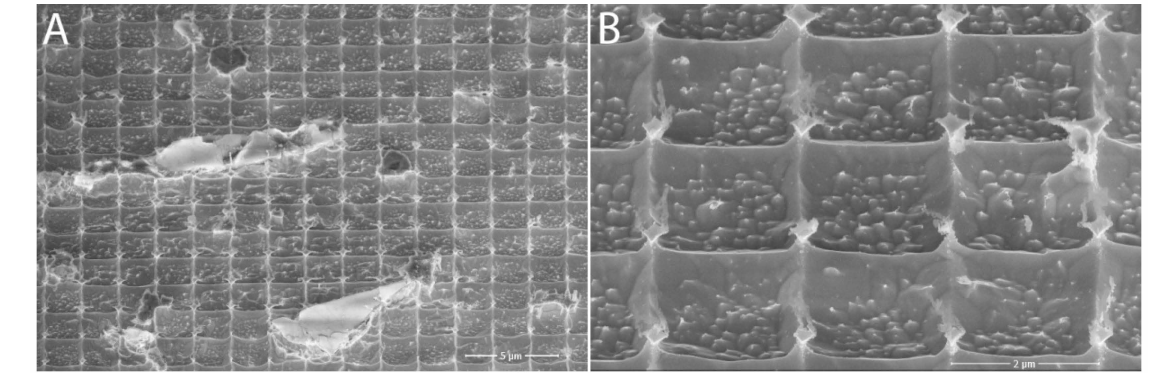
Figure 6. Lattice B2 under SEM microscope: ( A ) overall view including impurities; ( B ) closer view of the formed structure. Adapted from [15] with kind permission of Brno University of Technology.